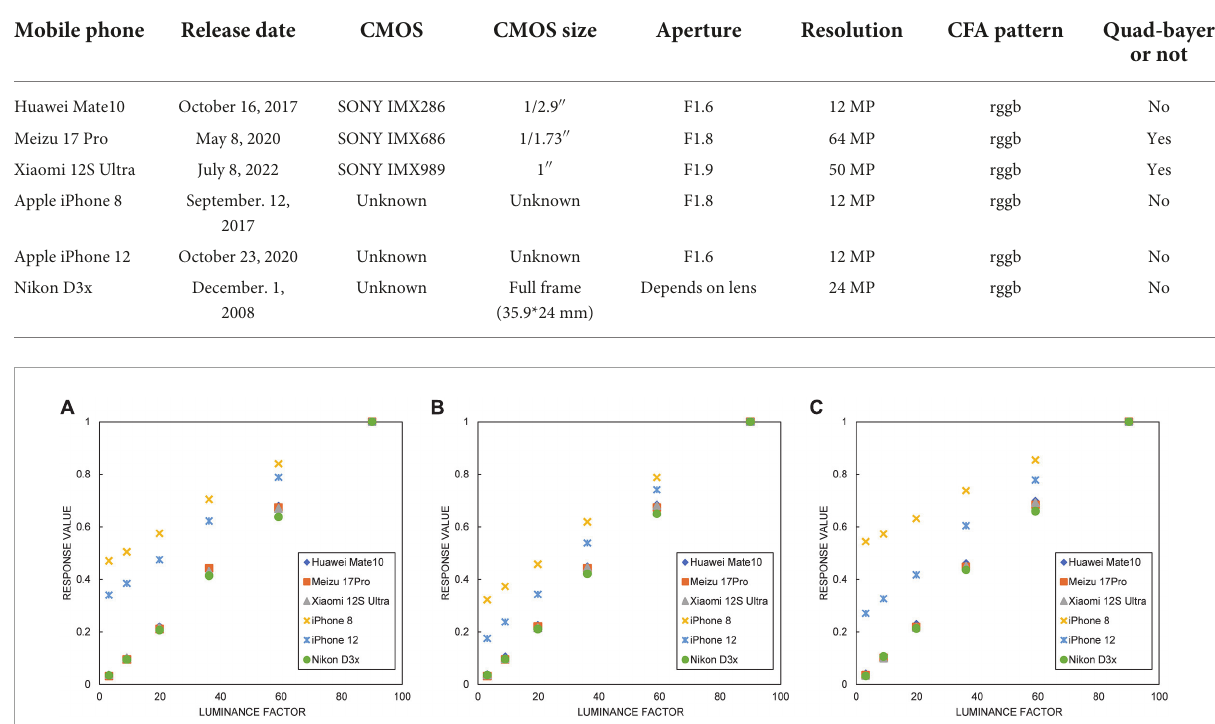
TABLE 1 Six imaging devices information.